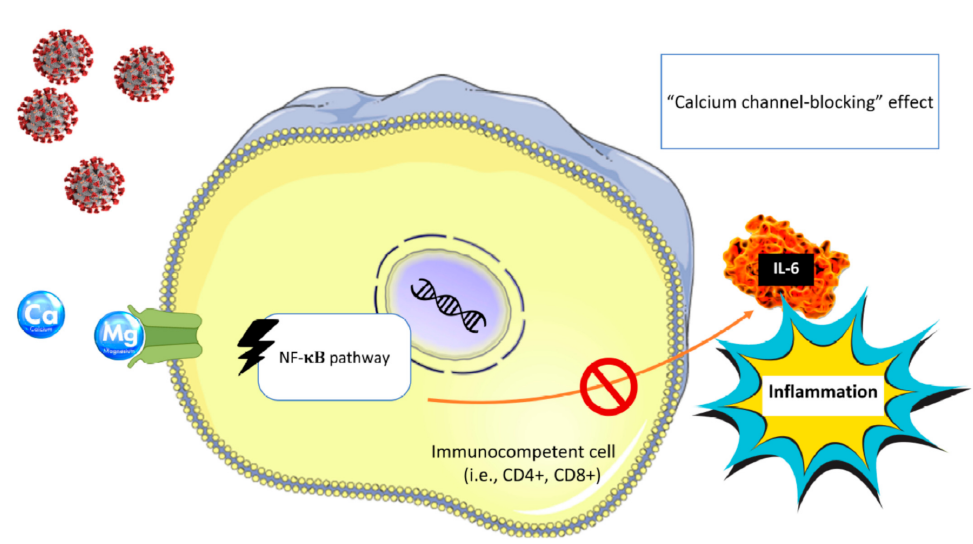
Figure 2. Mg’s “calcium channel-blocking” effect, which can lead to the downstream suppression of NF- κ B, IL-6 and may limit systemic inflammation. NF-kB: nuclear factor 70 kappa-light-chain-enhancer of activated B cells; IL-6: interleukin 6; CD4+: T helper cell; CD8+: cytotoxic T